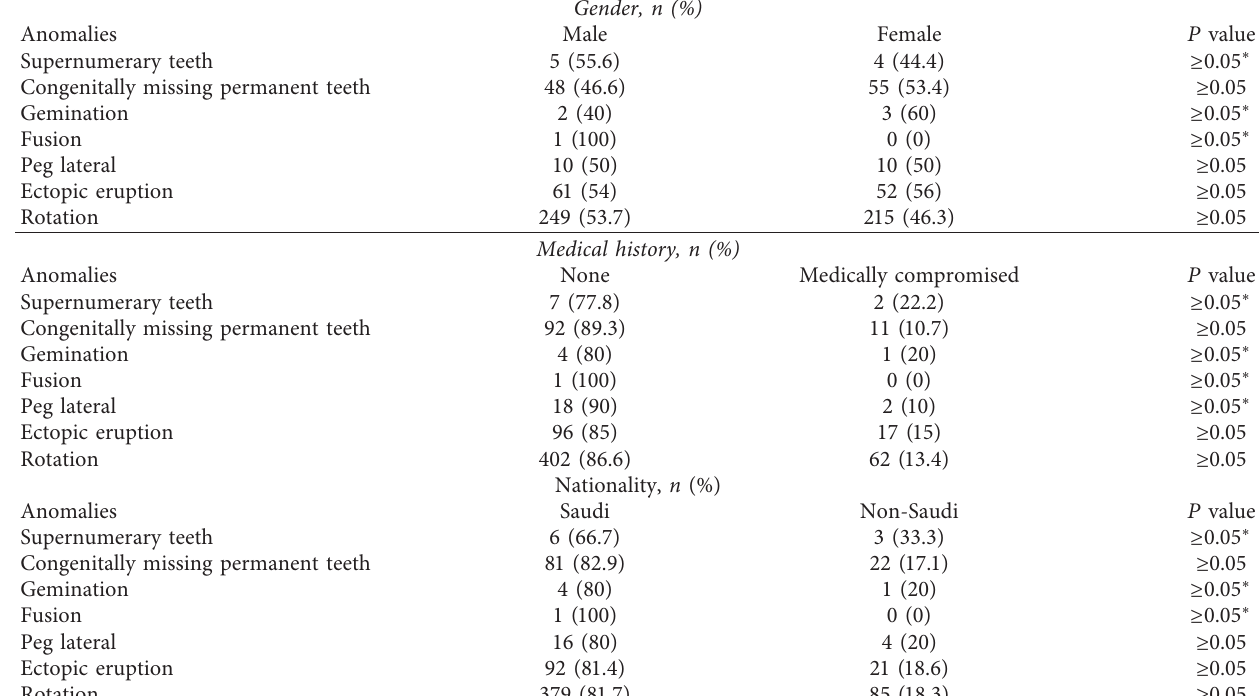
Table 3: Distribution of dental anomalies by gender, medical history, and nationality among children ( N �